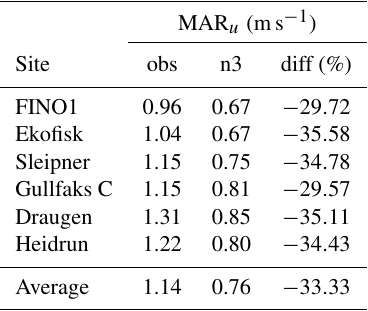
Table 6. Mean absolute ramp rate (MAR) in meters per second (ms − 1 ) for the observed and modeled wind speed ( u ). The differ- ence between the modeled and observed MAR u divided by the ob- served MAR u is given as a percentage (%).